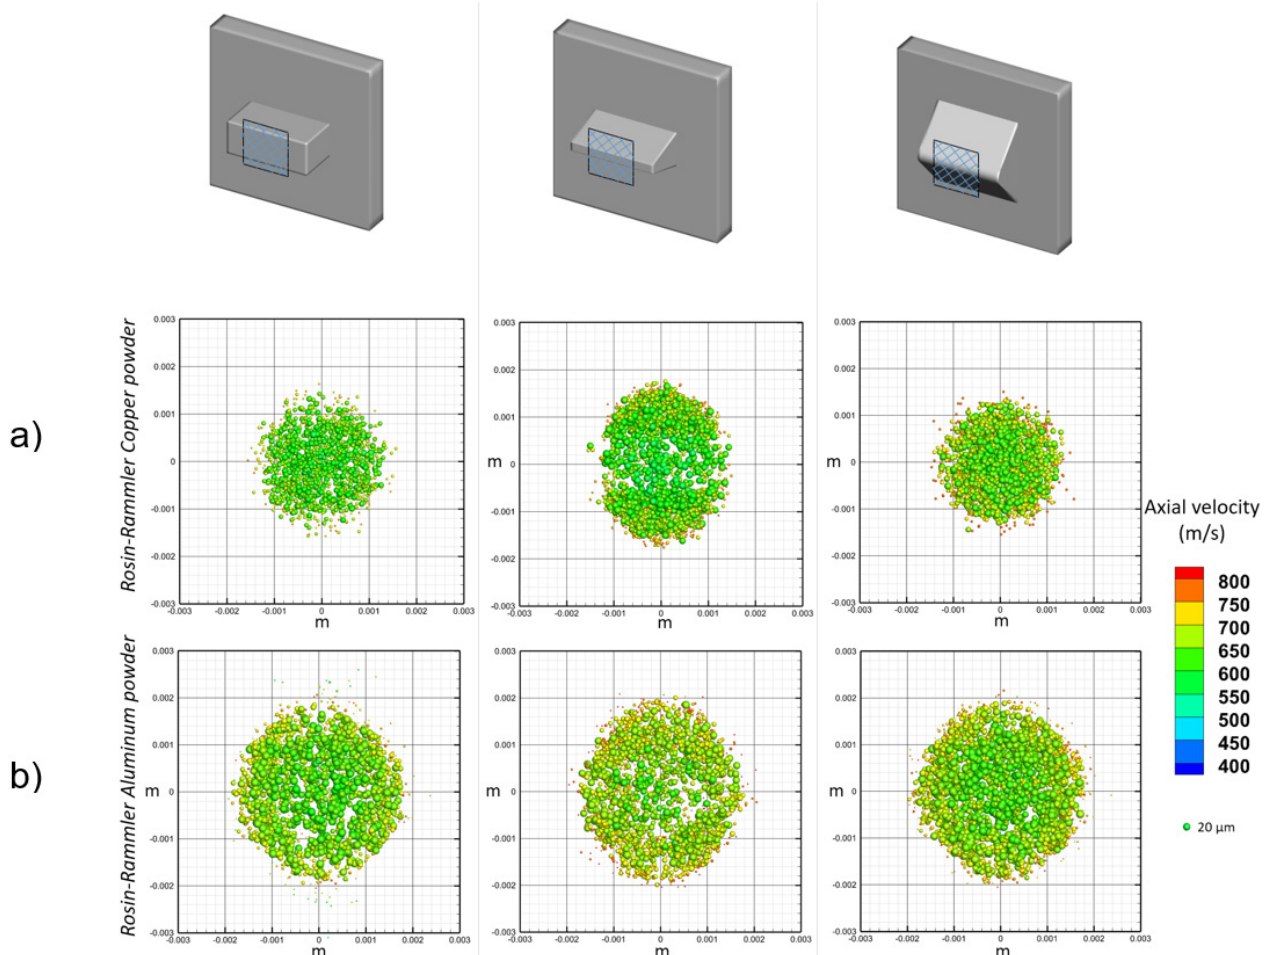
Figure 9. Distribution of ( a ) copper particles and ( b ) aluminum particles at SOD = 25 mm for the vertical wall (left), inclined wall (middle), and the smooth wall (right).